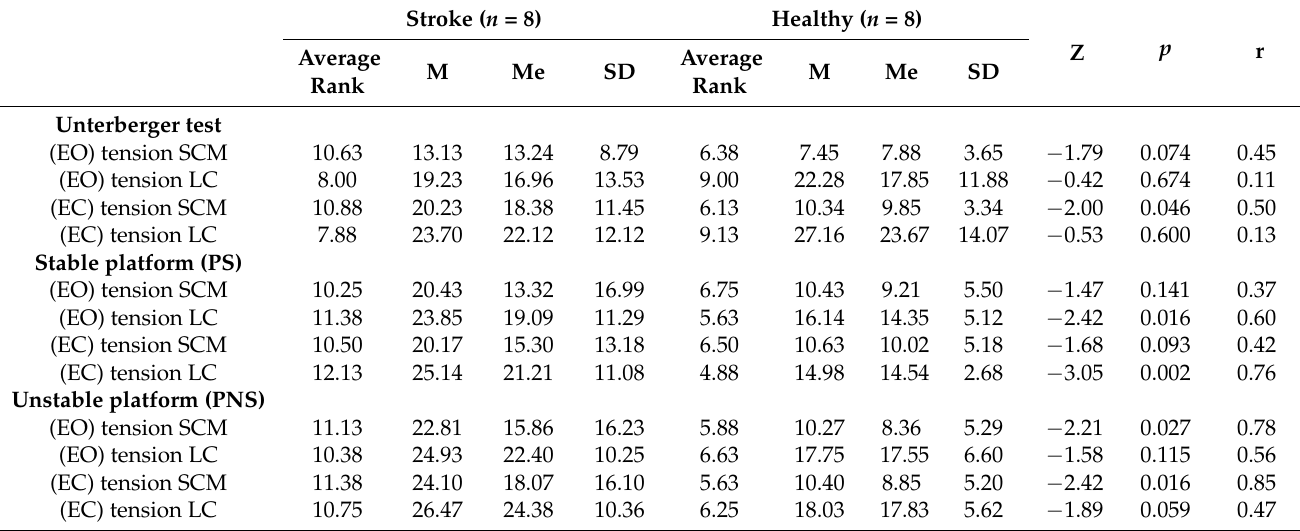
Table 6. Comparison of stroke patients and healthy patients in terms of the parameters measured. Stroke ( n =